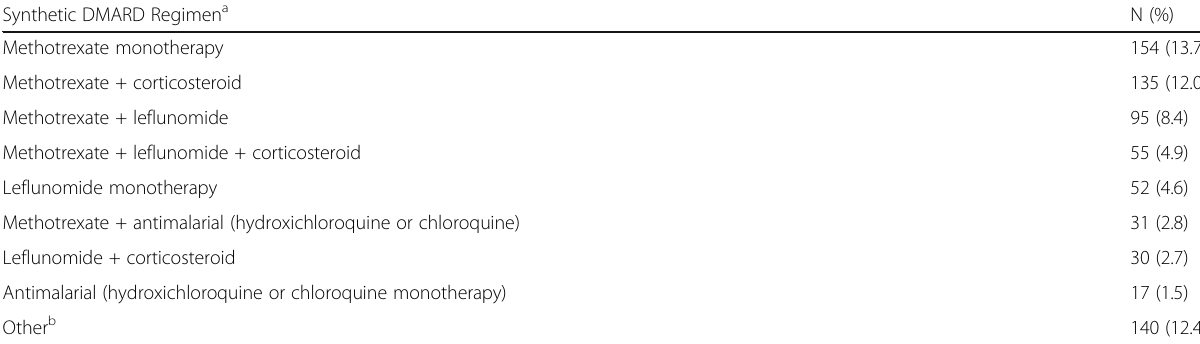
Table 4 Preferred therapeutic regimens of conventional synthetic disease-modifying antirheumatic drugs (DMARDs) in Brazil Synthetic DMARD Regimen a